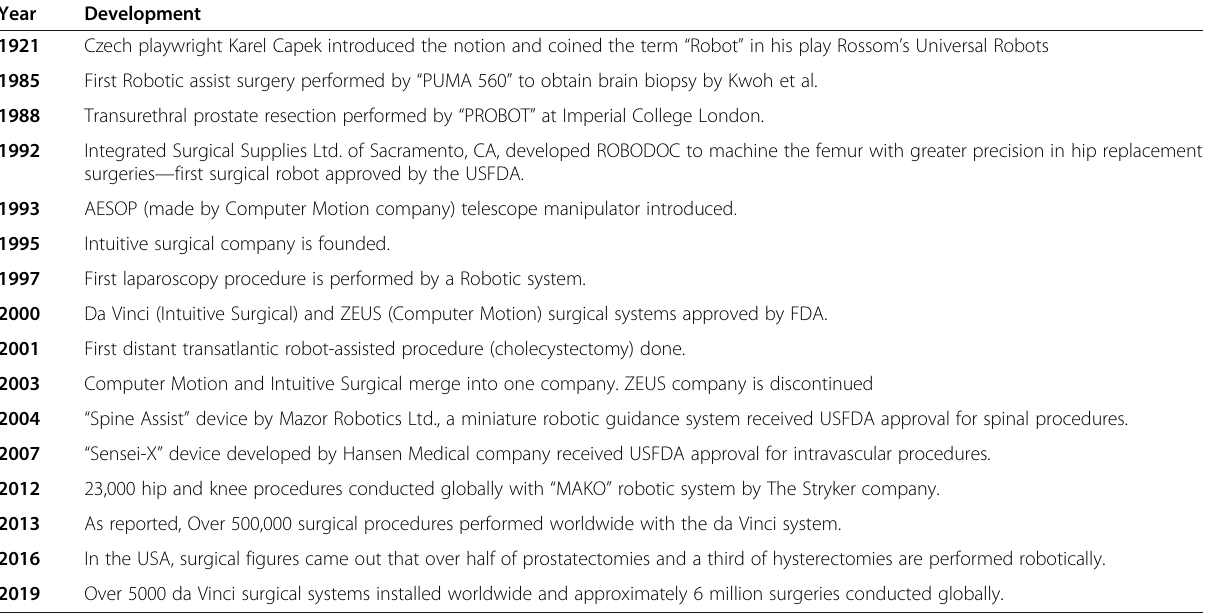
Table 2 Robotic surgery development